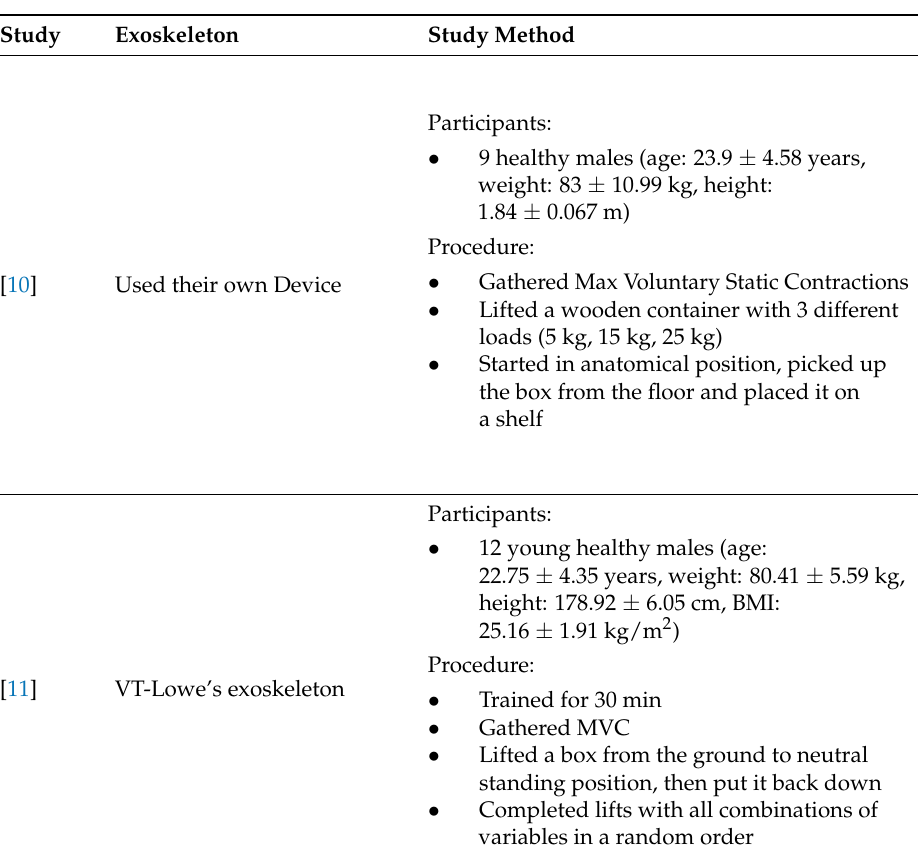
Table 3. Findings of reviewed studies on evaluation of